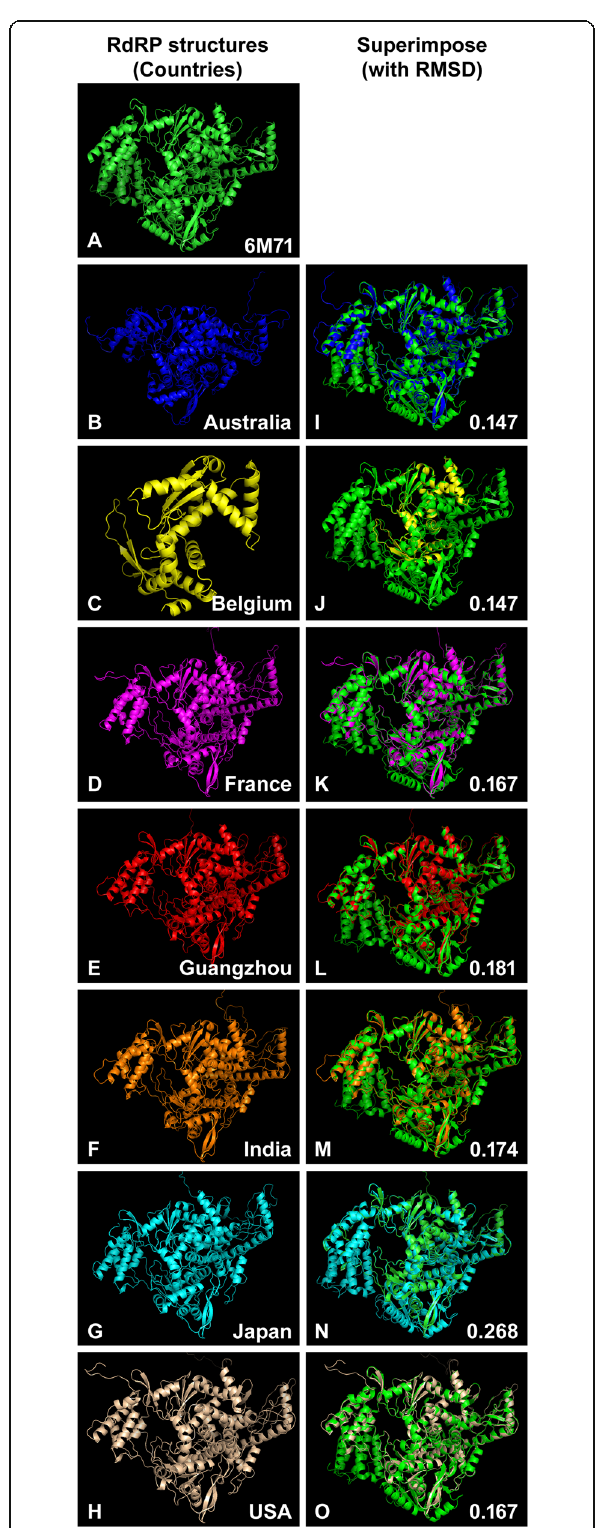
Fig. 3 Superimposition and comparison of RdRP structures of SARS- CoV-2. A Three-dimensional structure of 6M71 as template. B RdRP structures built with Modeller 9.24 for Australia (QJR96151.1). C Belgium (QIB84671.1). D France (QJT73032.1). E Guangzhou (China) (QJQ84086.1). F India (QJQ28427.1). G Japan (BCF74567.1). H USA (QJP03561.1). I Superimposition of 6M71 on built structures